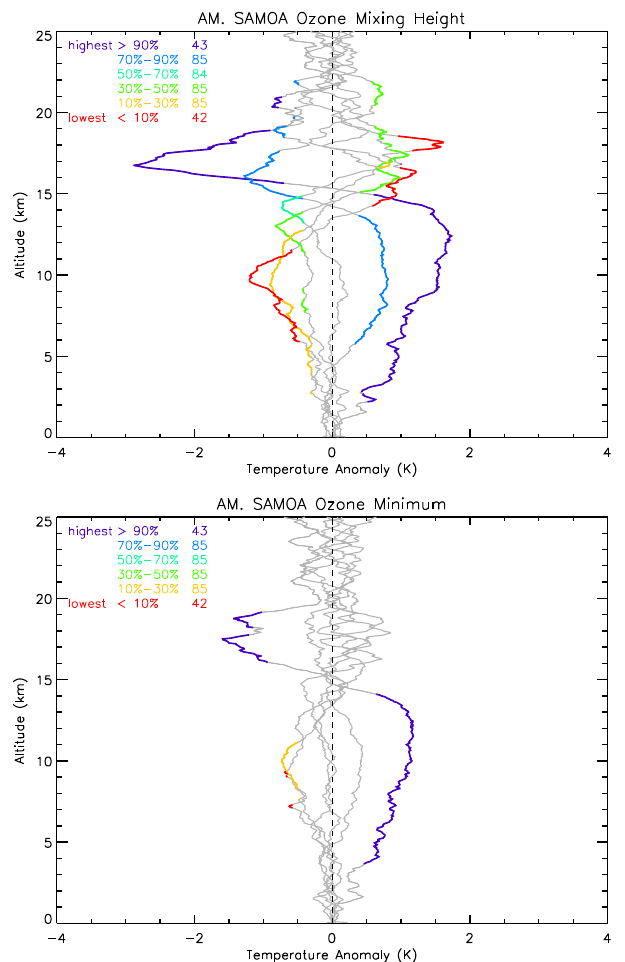
Fig. 5. Average profiles of temperature anomaly composited by (top) the height of the ozone mixing height and (bottom) the ozone minimum. Colored lines indicate where anomalies exceed the 95% significance level (with purple – highest and red – lowest heights). The number of profiles that make up each composite group appears next to the percentage.